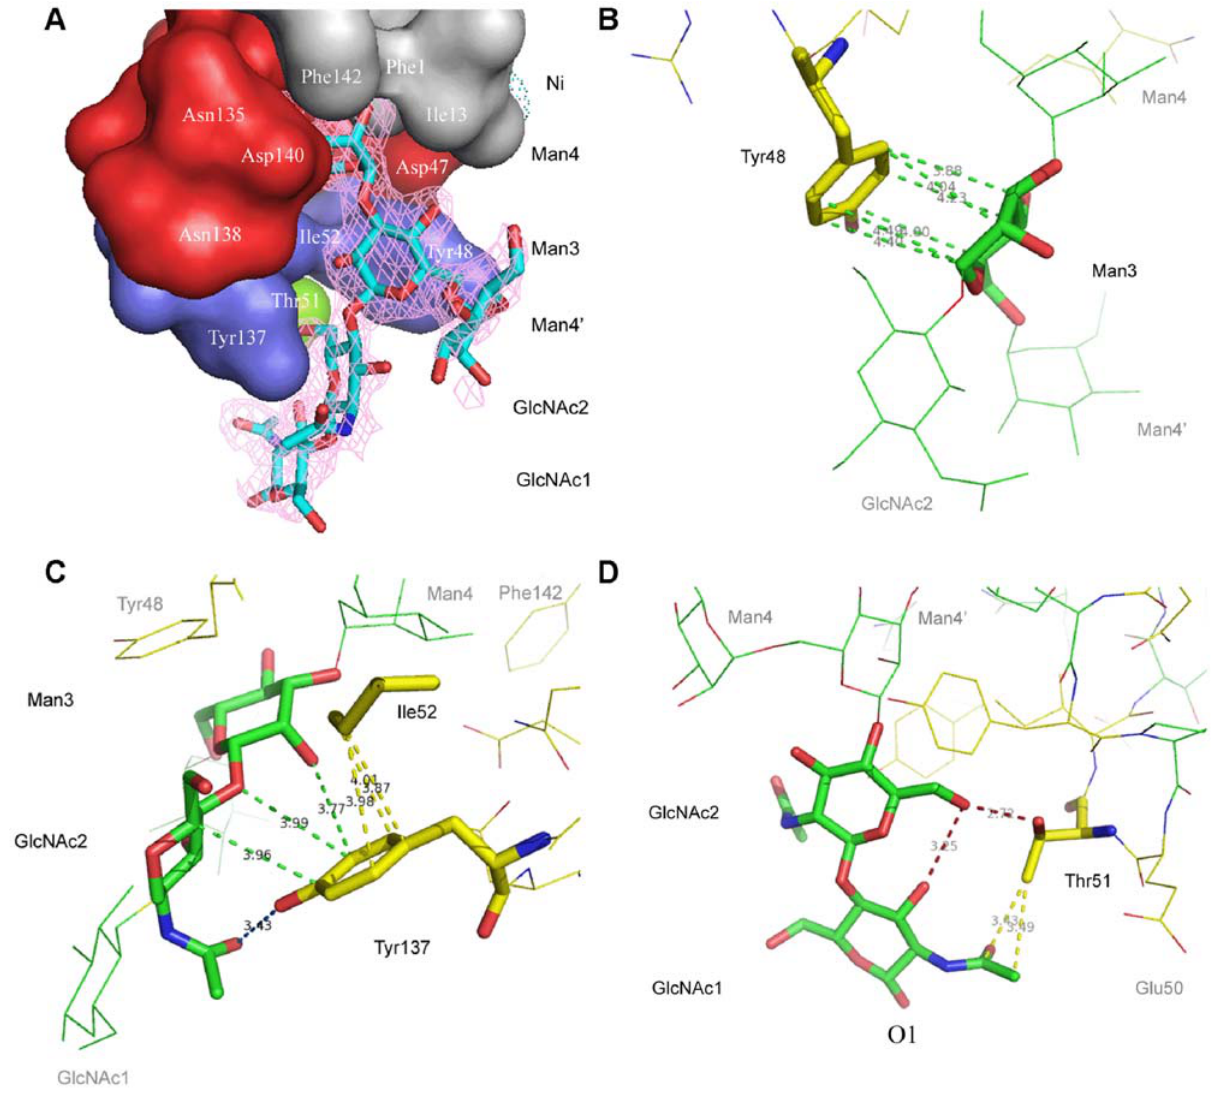
Figure 3. Panel of FimH lectin domain interactions along the oligomannose-3 chain. A , Electron density map, contoured at 1 e/A˚ 3 , for oligomannose-3 in the FimH receptor-binding site. The surface of the binding site is subdivided into its hydrophobic support platform (grey, residues Phe142, Phe1 and Ile13), its polar pocket (red, residues Asn46, Asp47, Asp54, Gln133, Asn135, Asn138 and Asp140), the tyrosine gate (blue, residues Tyr137, Ile52 and Tyr48) and residue Thr51 (green). B , Aromatic-to-saccharide stacking (green dashed lines) of the Tyr48 side chain onto the B-face of Man3. C , van der Waals support of the b 1,4 linkage (yellow dashed lines) and an hydrophobic contact of C5 of GlcNAc2 by Tyr137 (green dashed lines). D , Thr51 tops of the site by hydrophilic (red), hydrophobic and van der Waals (yellow) interactions with the chitobiose. The anomeric O1 of GlcNAc1 would be exchanged for by the nitrogen of the amide of aspargine on a receptor glycoprotein for FimH.